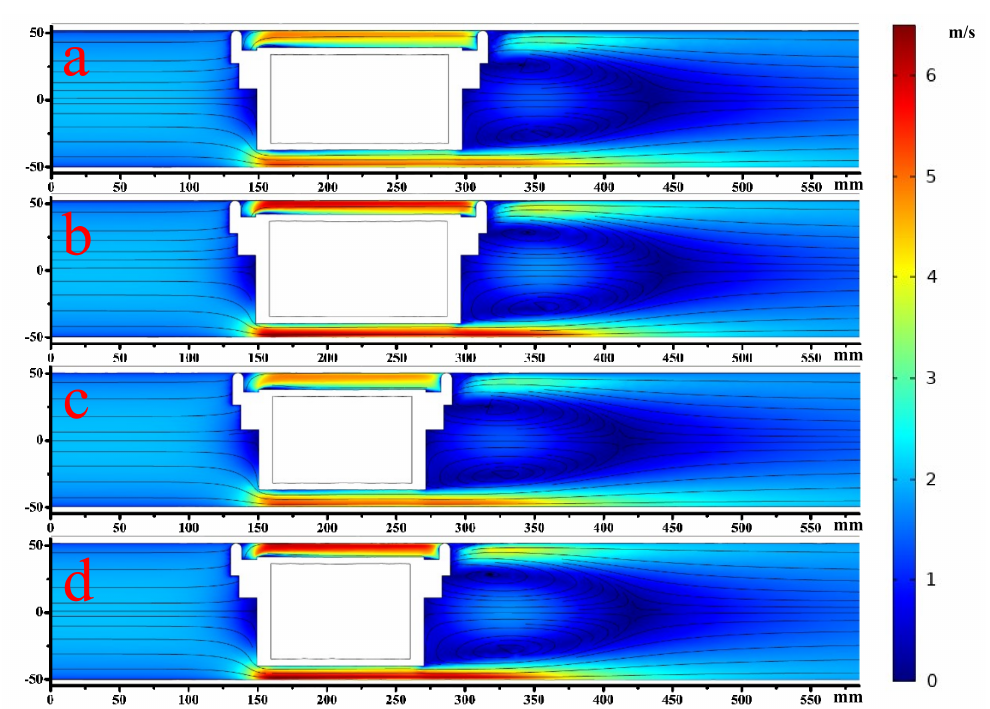
Figure 10. The velocity distribution cloud of the XZ plane of di ff erent sizes piped carriage with the discharge of 50 m 3 · h − 1 . Note: ( a ) D c × L c = 75 mm × 150 mm; ( b ) D c × L c = 80 mm × 150 mm; ( c ) D c × L c = 75 mm × 120 mm; ( d ) D c × L c = 80 mm × 120